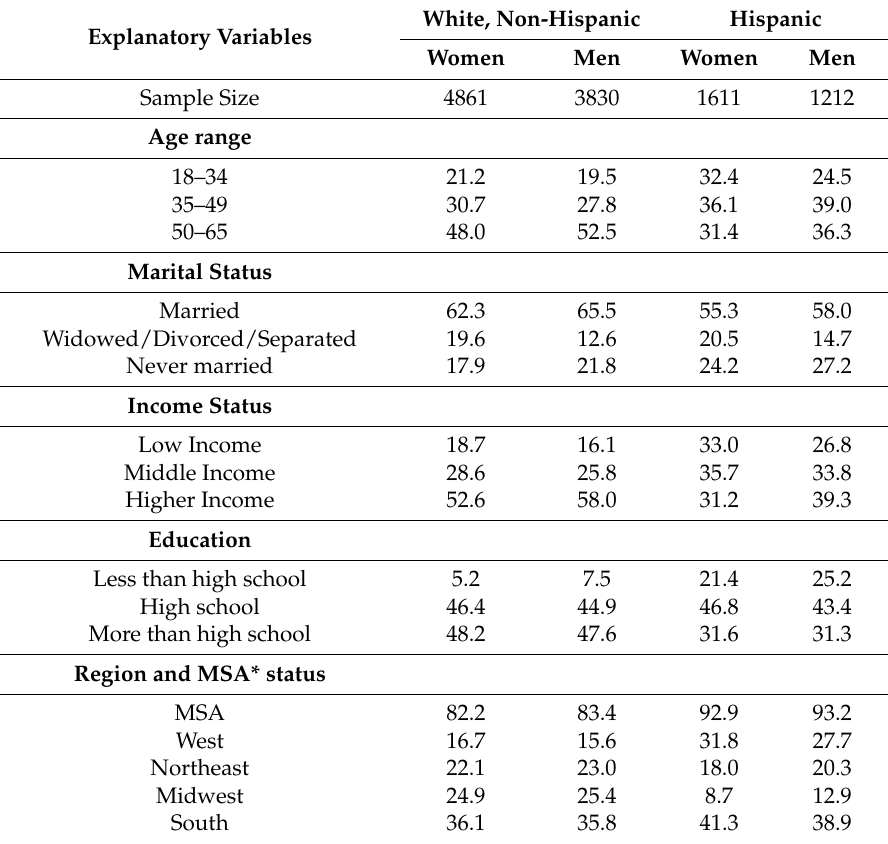
Table 1. Characteristics of Study